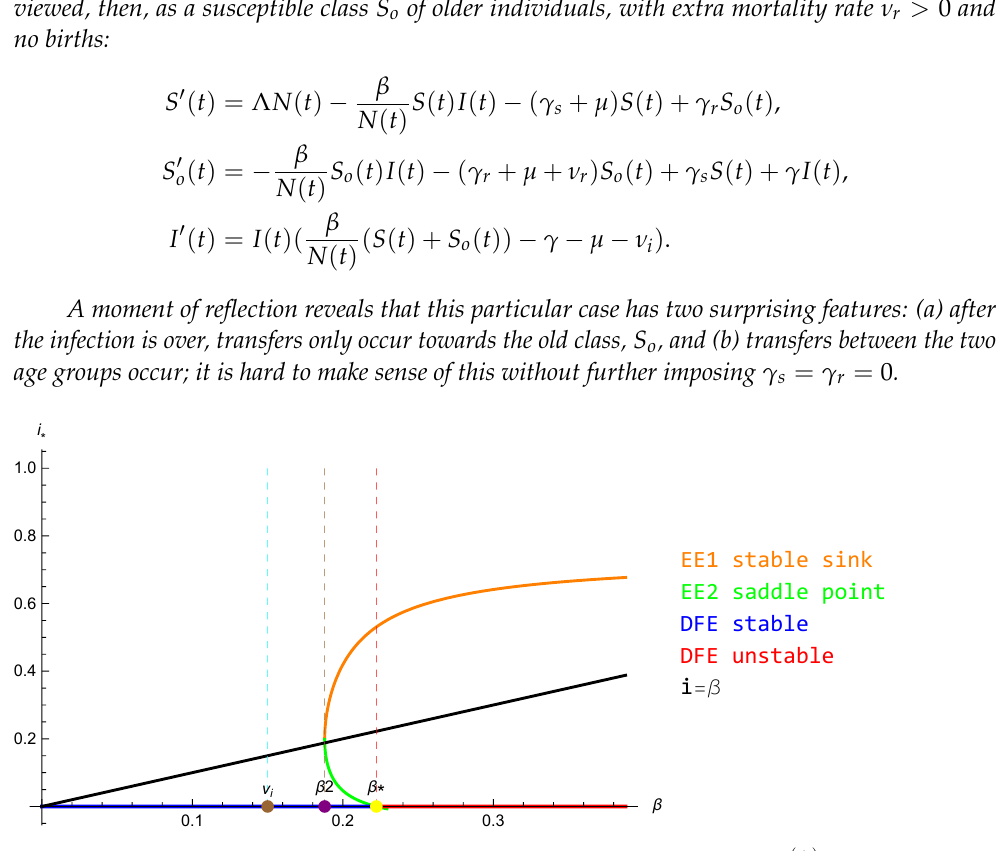
Figure 5. Diagram bifurcation with respect to β , in the case max [ Λ + γ + ν i , β